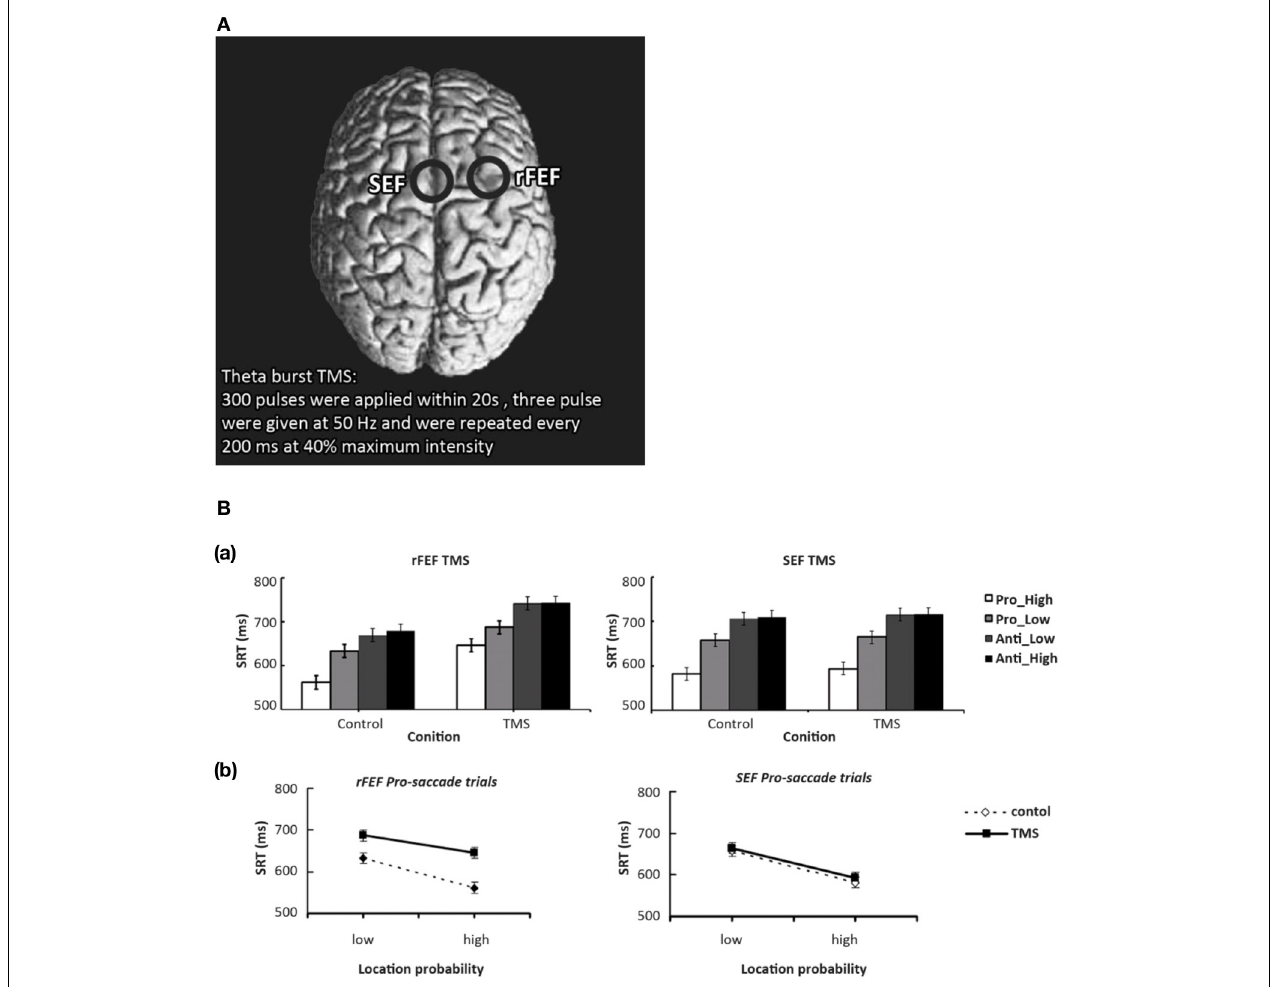
FIGURE 3 | (A) Locations of FEF and SEF. Theta burst TMS was used in this series of experiments. (B) FEF TMS modulates the location probability effect on saccade latency, results from Liu et al. (2011). Mean saccadic RTs as a function of TMS, saccade type, and probability. The top two panels indicated FEF and SEF TMS conditions, respectively. In FEF TMS condition, the pattern of the location probability effect was affected by TMS and also the general